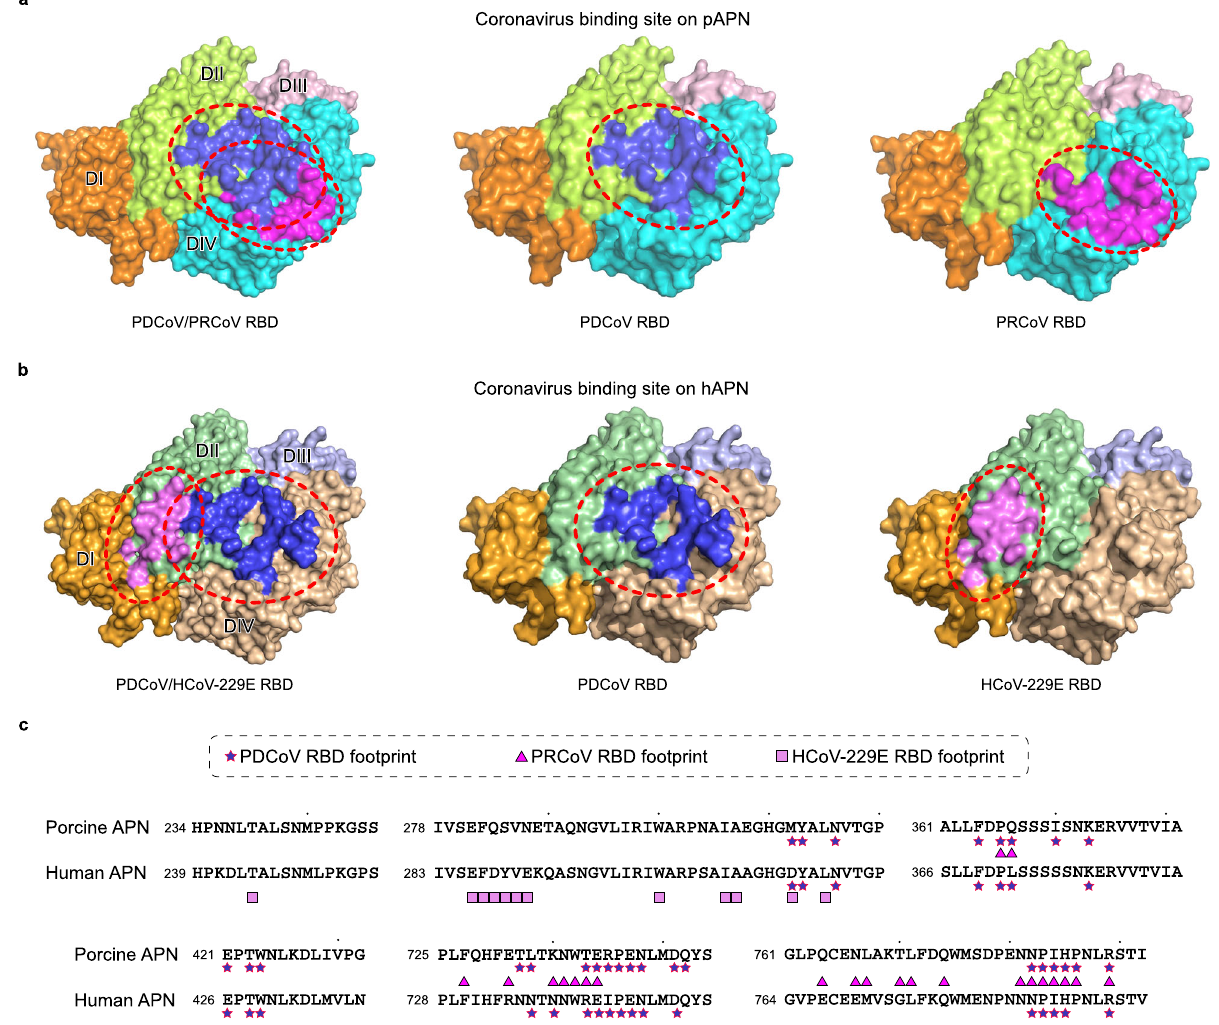
Fig. 2 PDCoV binds to sites on APN that are different from alphacoronaviruses HCoV-229E and PRCoV. a (Left panel) Overlay of PDCoV and PRCoV footprints on pAPN. pAPN is shown as surface representation, with DI – DIV colored in orange, light green, pink, and cyan respectively. Residues on pAPN contacting PDCoV RBD and PRCoV RBD are colored in blue and magenta, respectively. The boundaries of PDCoV and PRCoV footprints are circled with red dotted lines. (Middle panel) PDCoV RBD footprint on pAPN. (Right panel) PRCoV footprint on pAPN. PDCoV RBD footprint engages both DII and DIV of pAPN while PRCoV RBD largely targets DIV of pAPN. b (Left panel) Overlay of PDCoV and HCoV-229E footprints on hAPN. hAPN is depicted as surface representation. DI – DIV of hAPN are colored in orange, dark green, light blue, and brown, respectively. Residues on hAPN that bind to PDCoV RBD and HCoV-229E RBD are colored as in ( a ). The boundaries of PDCoV RBD and HCoV-229E RBD binding sites are circled with red dotted lines. (Middle panel) PDCoV RBD footprint on hAPN. (Right panel) HCoV-229E footprint on hAPN. PDCoV RBD binding sites on hAPN are also located both on DII and DIV of hAPN, whereas HCoV-229E RBD mainly binds to DII of APN. c Sequence alignment of pAPN and hAPN. Residues on pAPN/hAPN binding to PDCoV RBD, PRCoV RBD, and HCoV-229E RBD are marked according to the code of the key above the